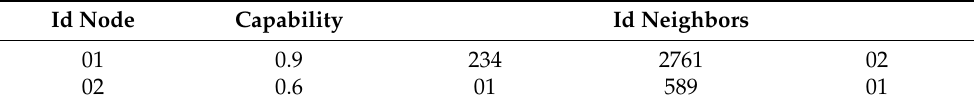
Table 3. A sample dataset of nodes’ information and capabilities used in the simulations. Id Node